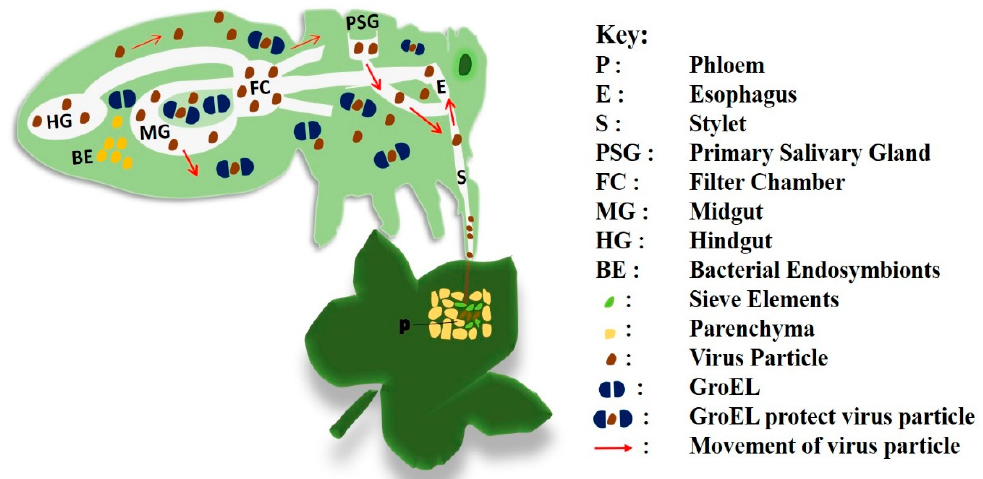
Figure 1. The transmission cycle starts with virus acquisition from the phloem of an infected plant. The virus particles (brown) move along the stylet, foregut, and esophagus and reach the midgut in whiteflies. GroEL (blue) is required for protection (blue-brown-blue), circulation, and transmission of virus particles.